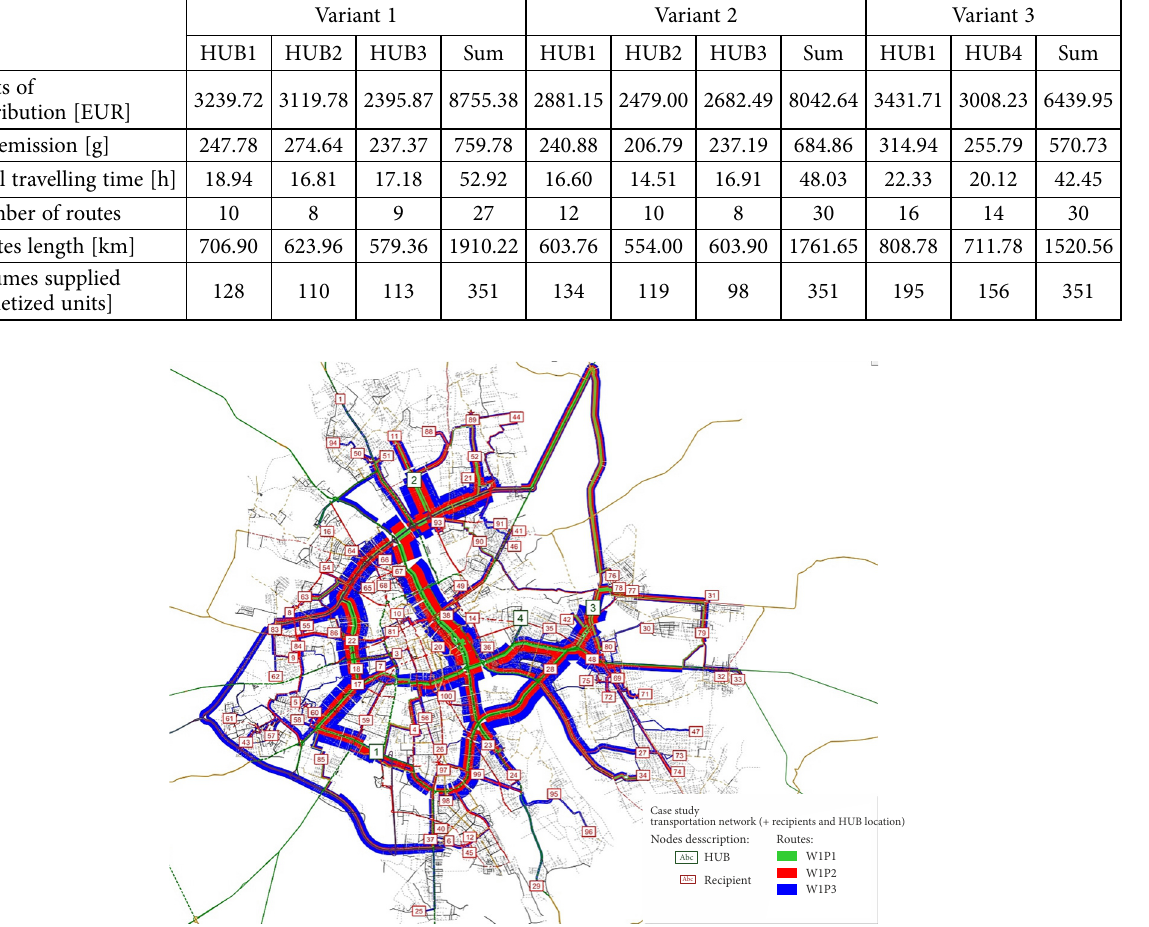
Fig. 2. Routes in variant